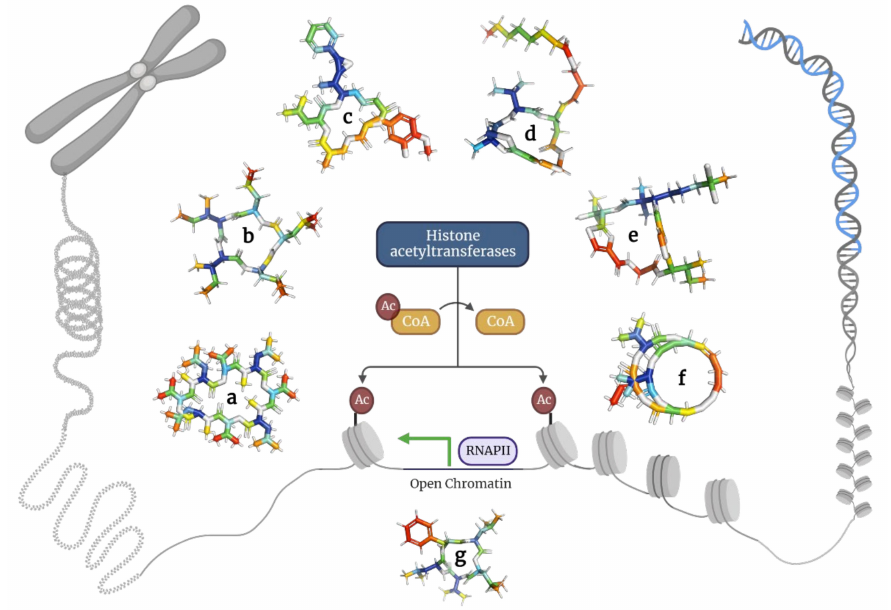
Figure 5. Depsipeptides inhibiting histone acetyltransferases in tumor cells. ( a ) Bassianolide; ( b ) Clava-